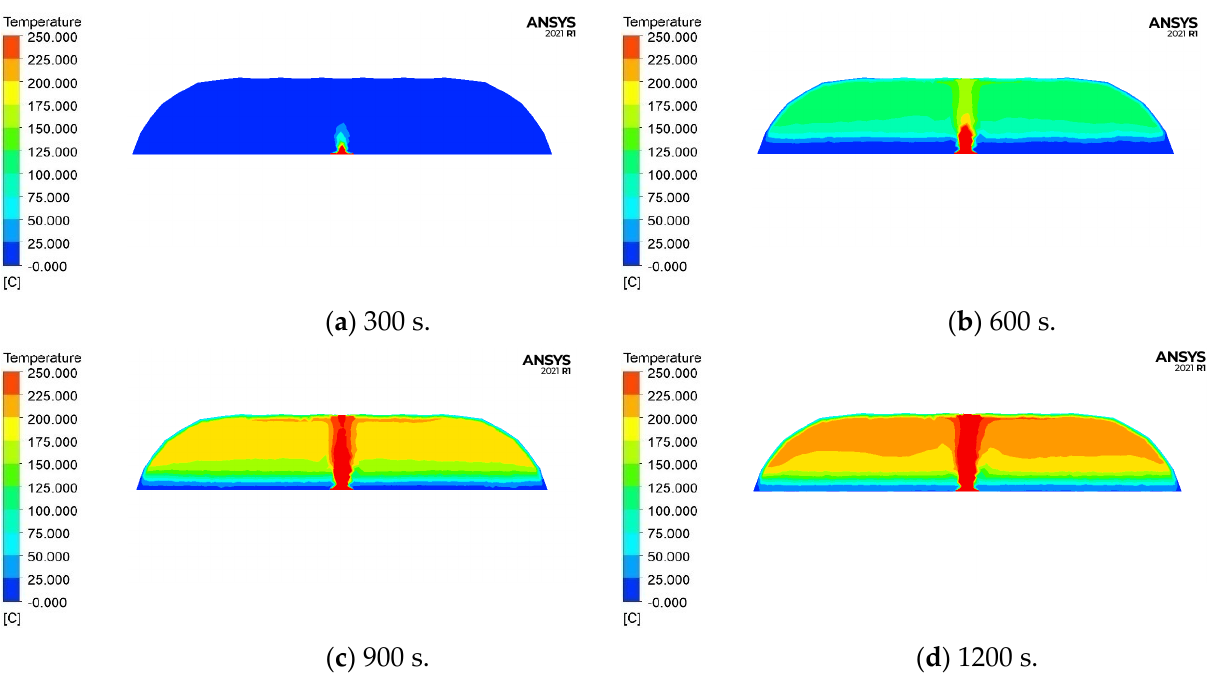
Figure 6. Temperature of the structure in the normal-grow fire event.